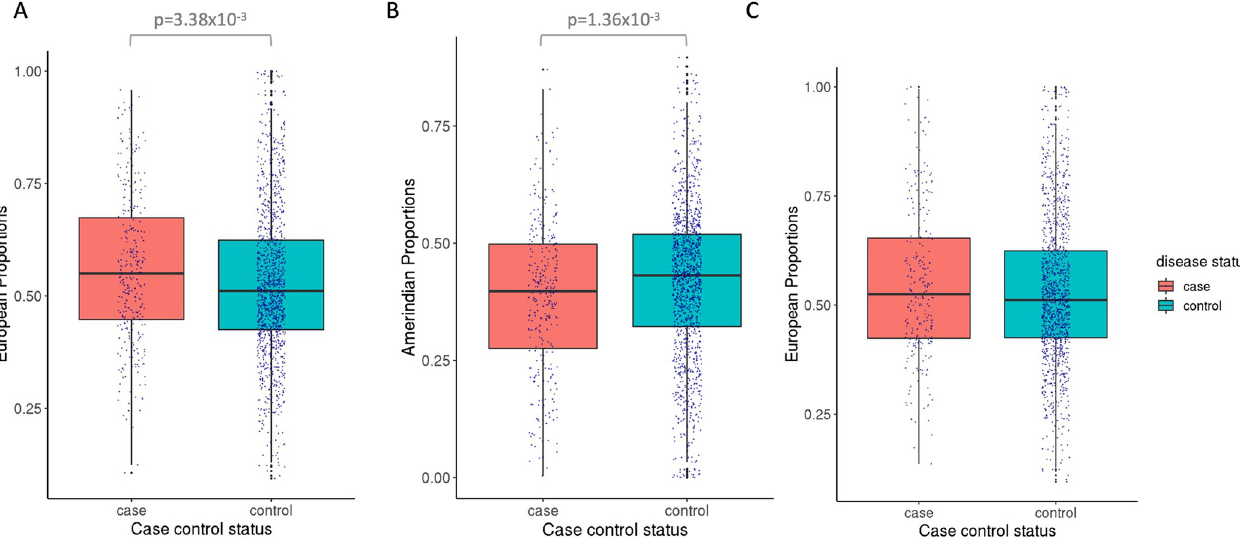
Fig 3. Distribution of ancestry proportions in Latino pilocytic and non-pilocytic astrocytoma cases and controls: 3A . boxplot showing distribution of estimated global European ancestry proportion in Latino pilocytic case and control subjects. Cases have a higher median proportion of European ancestry proportion than controls. 3B. boxplot showing distribution of estimated global Amerindian ancestry proportions, and in correspondence with 3A, cases have a lower median proportion of Amerindian ancestry proportion than controls. 3C. a boxplot showing distribution of estimated global European ancestry proportion in Latino non-pilocytic case and control subjects. Comparing to pilocytic astrocytoma, cases have a similar median proportion of European ancestry proportion to controls. Statistical analysis shows no significant difference between cases and controls.